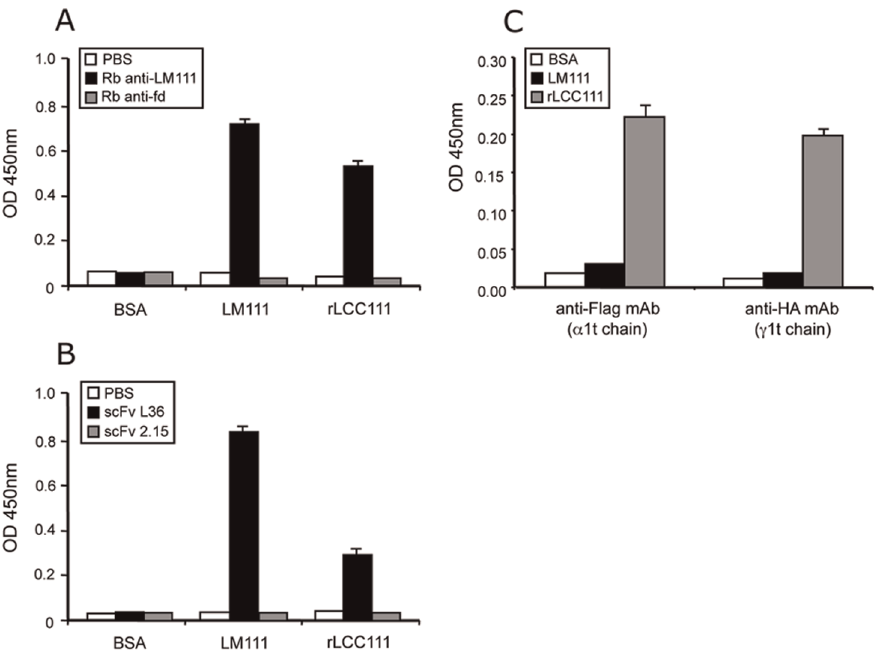
Figure 3. ELISA to assay binding of rabbit anti-laminin antibody (A) and the anti-laminin scFv antibody L36 (B) to plastic coated with LM111 or with rLCC111. As control, we used rabbit anti-fd-bacteriophage antibody (A) and the anti-p32 scFv antibody 2.15 (B). ELISA to demonstrate the presence in the same rLCC111 molecule of two truncated laminin chains, t a 1 and t b 1 or t c 1 and tb1 (C).